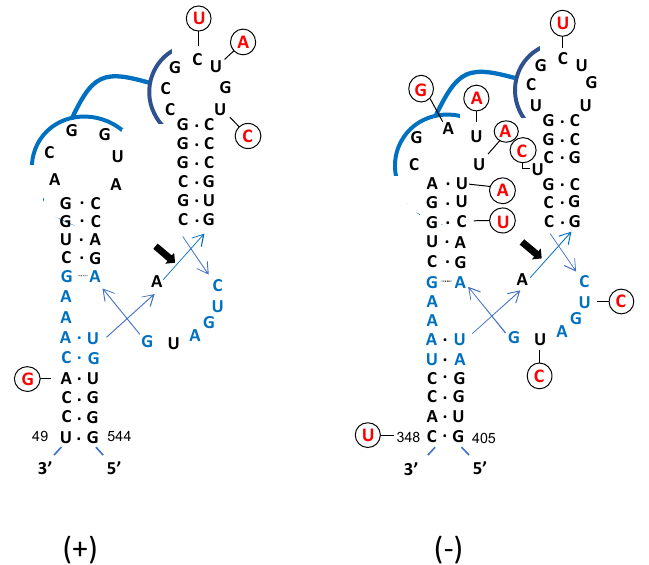
Figure 4. Primary and secondary structure of hammerhead ribozymes (HHRzs) of (+) and ( − ) CtaHVd-LR1. The nucleotides of the catalytic core conserved in most natural hammerhead structures are in blue. The cleavage site of each ribozyme is indicated by an arrow. Nucleotides in the loops of both HHRzs potentially involved in tertiary interactions are marked by blue lines. Nucleotides in the (+) and ( − ) polarity are numerated considering their positions in the variant CtaHVd-LR1_3. Mutations observed in other variants are indicated in circles, with the compensatory mutations and those not modifying the proposed secondary structure of the HHRzs reported in red.